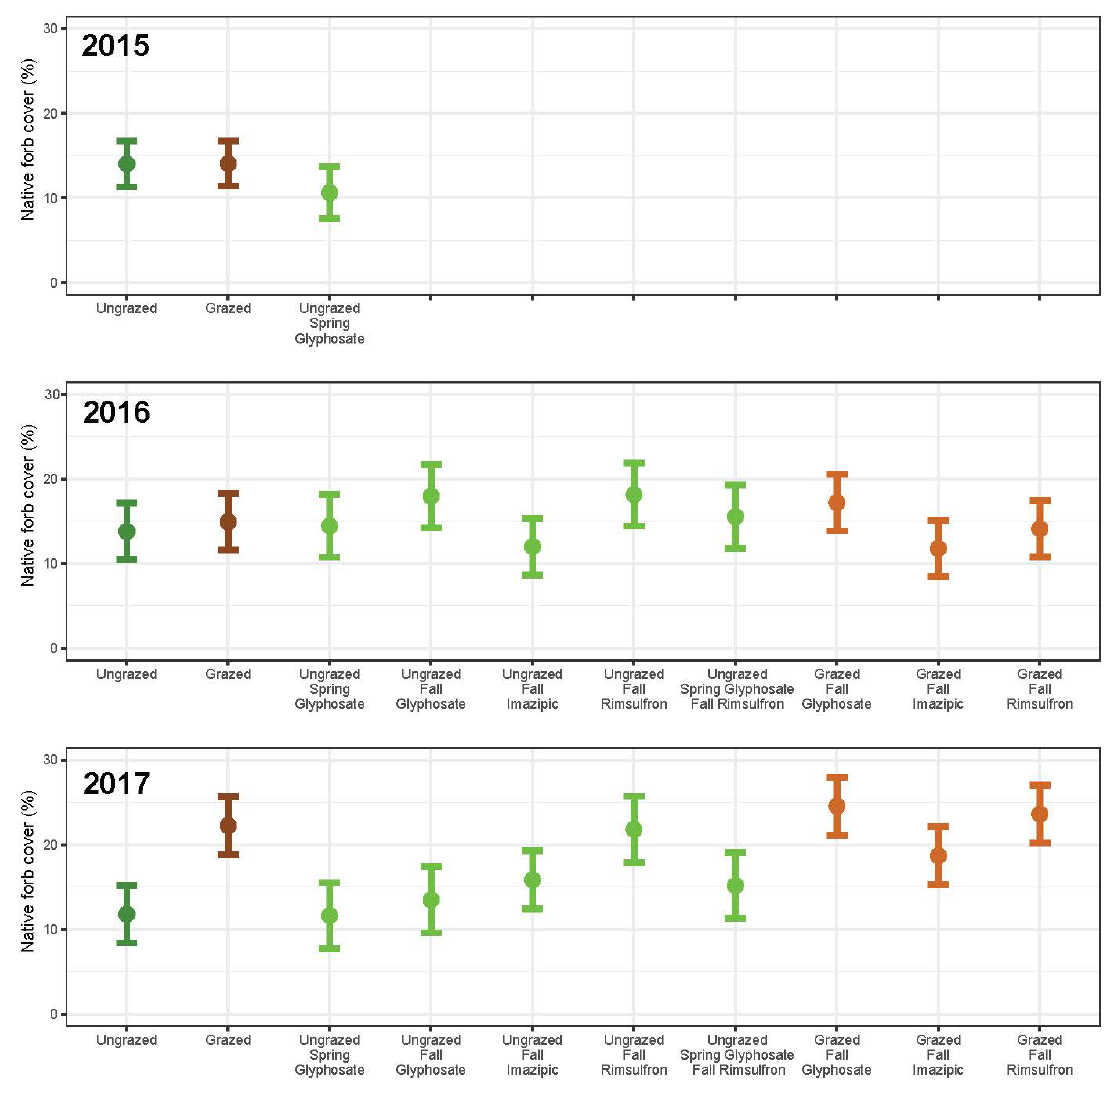
Figure 5. Fitted model results for forb cover (%; mean ± SE) response to grazing, herbicide, and integrated treatments at Red Blu ff , Montana in 2015, 2016, and 2017. Fall herbicide treatments were implemented after summer data collection in 2015, so these treatments do not show results in 2015. Furthermore, fall herbicide results in 2016 and 2017 represent treatments implemented in the prior years. Data shown are predicted values from linear mixed e ff ects models, and thus the means are not identical to means from the raw